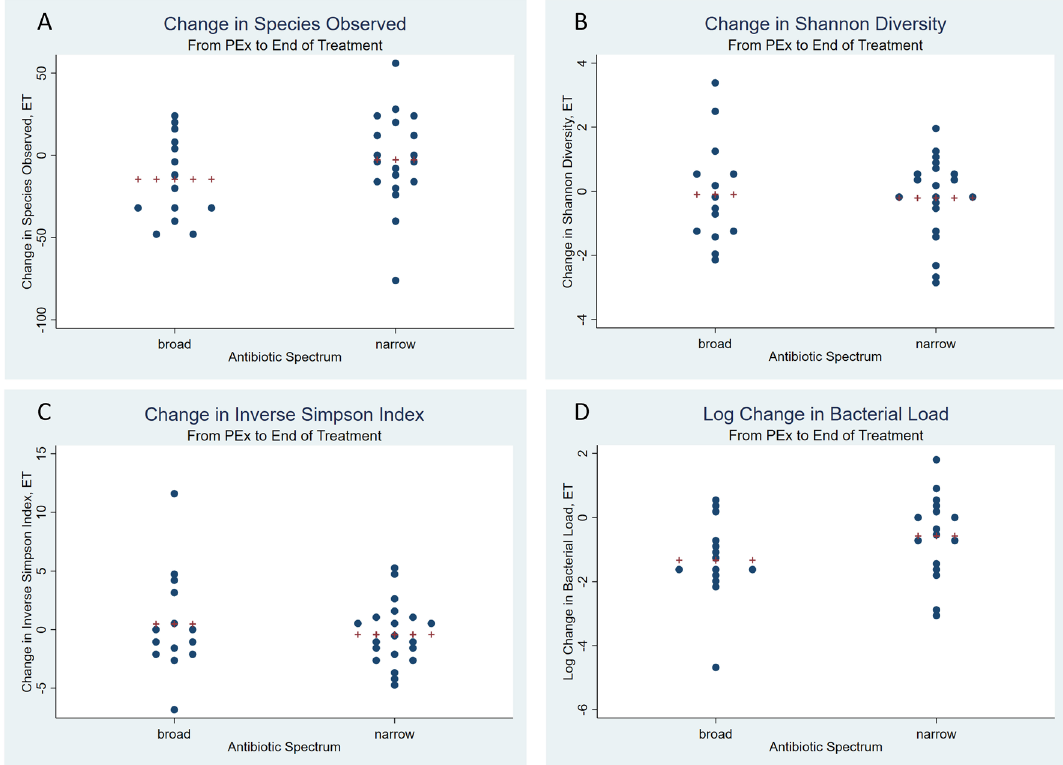
Figure 2. Change in alpha diversity and bacterial load by antibiotic spectrum exposure from pulmonary exacerbation to end of antibiotic treatment. Panel ( A ) Change in Species Observed. Panel ( B ) Change in Shannon Diversity. Panel ( C ) Change in Inverse Simpson Index. Panel ( D ) Log Change in Bacterial Load. PEx, pulmonary exacerbation; E, pulmonary exacerbation; T, end of treatment; ET, change between pulmonary exacerbation and end of treatment. Plus signs represent the